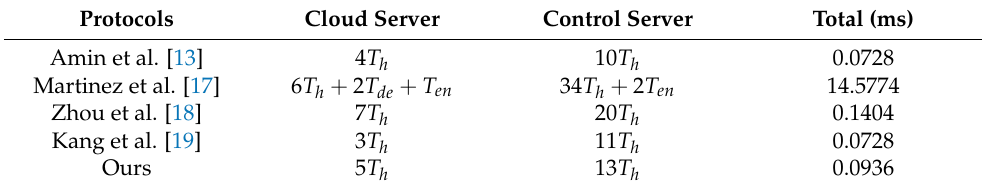
Table 6. Comparative results of server computational